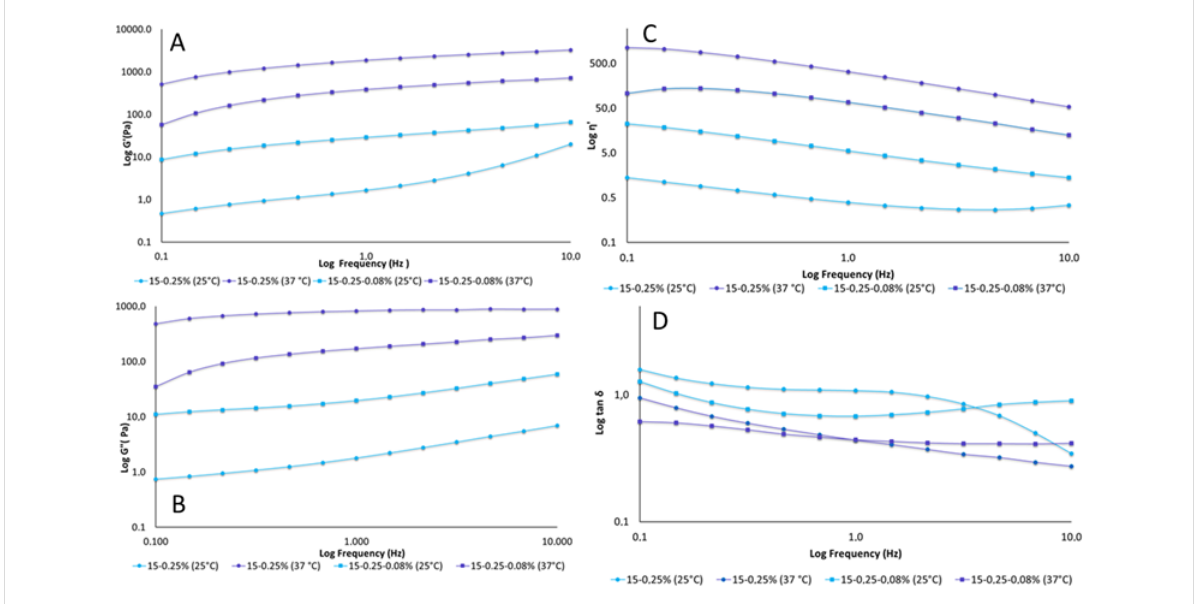
Figure 7: (A) Elastic modulus, G’ (Pa), (B) viscous modulus, G” (Pa), (C) dynamic viscosity, η ’ (Pa), and (D) tan δ of the formulations containing P407 (15%, w/w) and C974P (0.25%, w/w) with and without CUR (0.08%, w/w) evaluated at 25 and 37 °C. Each point represents the average of at least three replicates with a variation coefficient lower than